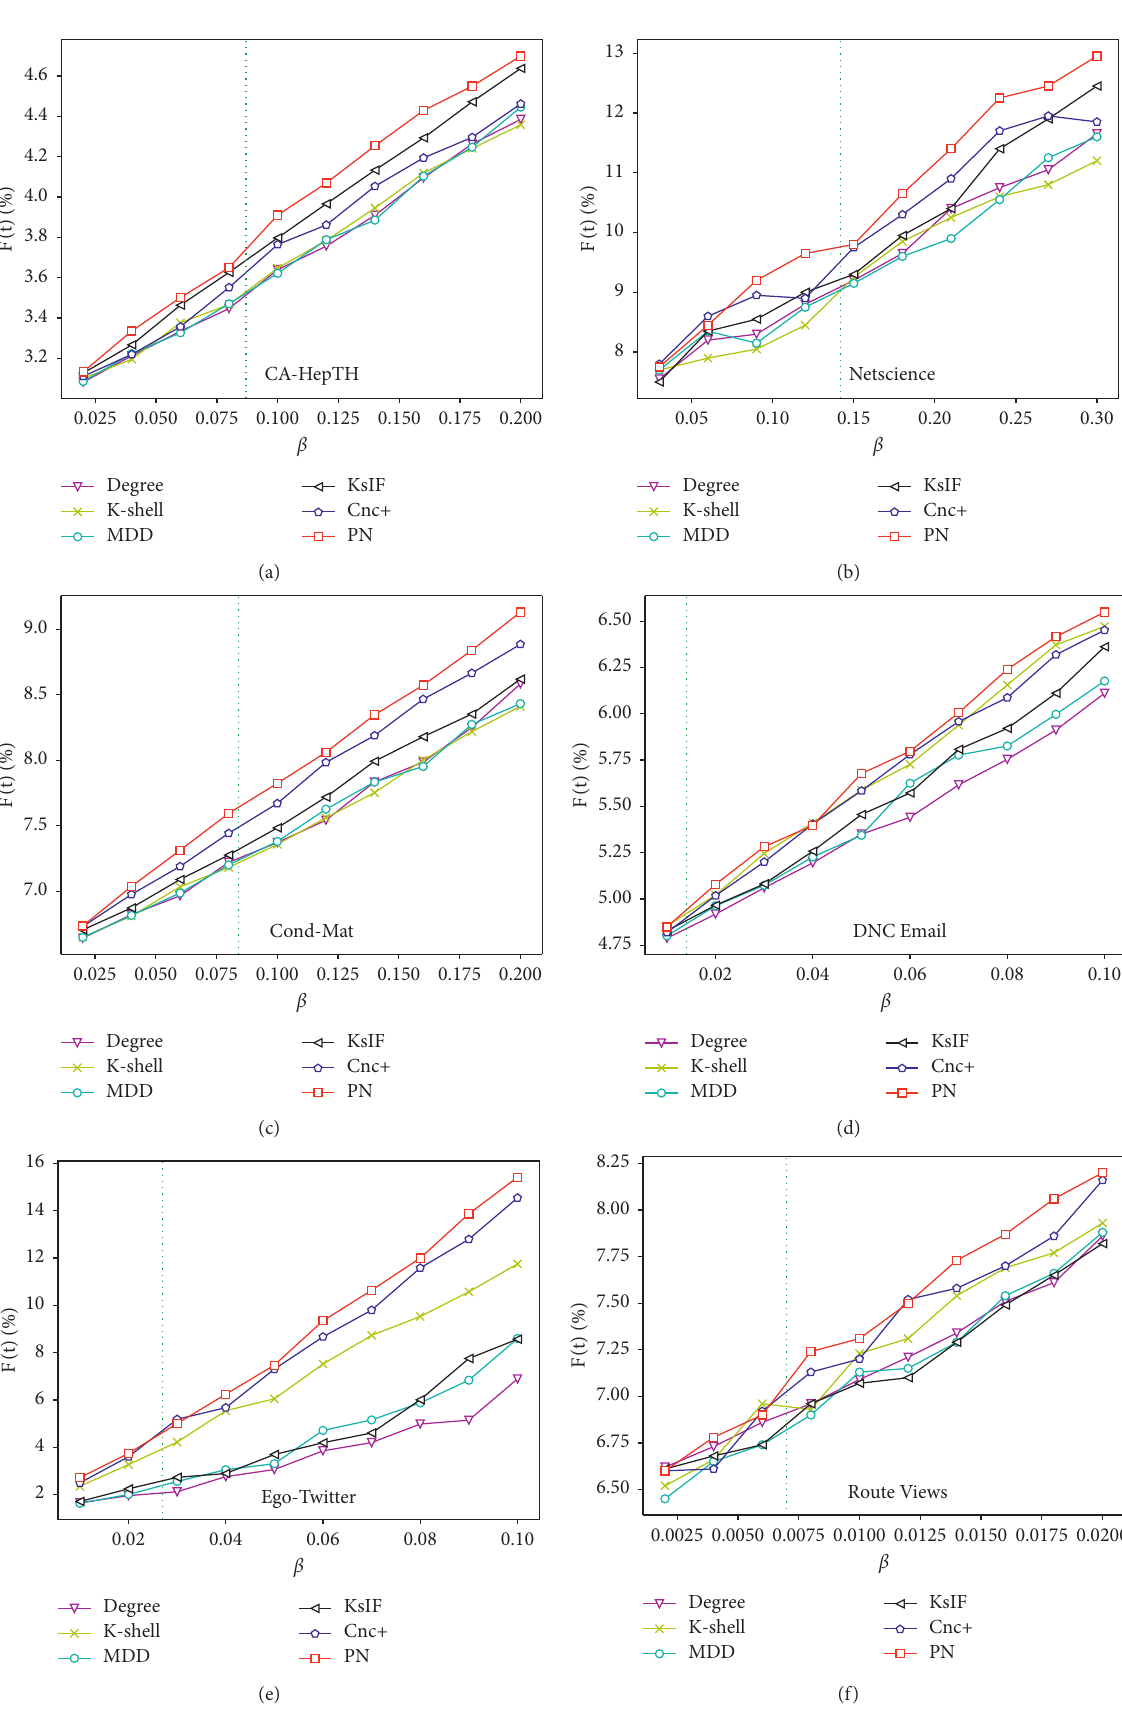
Figure 3: The propagation capability graph of the five methods under different propagation probabilities. The experiments are simulated on six different datasets: CA-HepTh (a), Netscience (b), Cond-Mat (c), DNC Email (d), Ego-Twitter (e), and Route Views (f). The green vertical line is the epidemic threshold of the corresponding